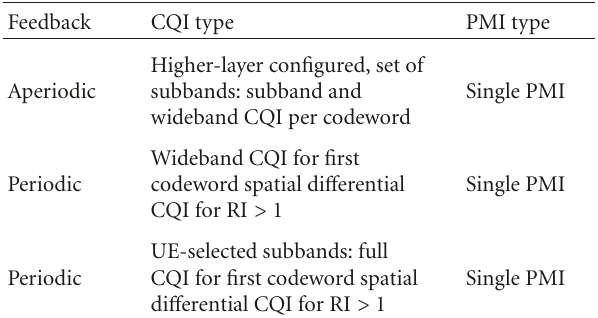
Table 1: CQI and PMI feedback types for transmission mode 5